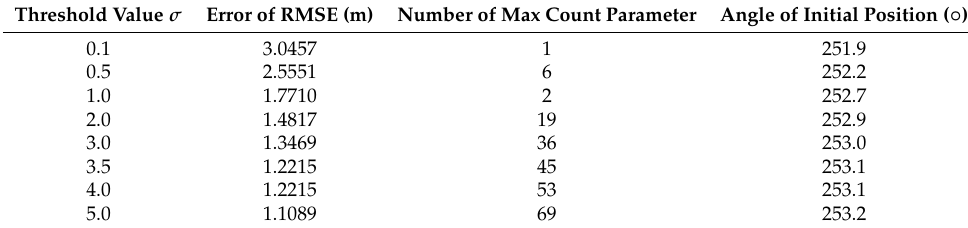
Figure 9. Performance analysis of different threshold values. Table 3. Simulation results of different threshold